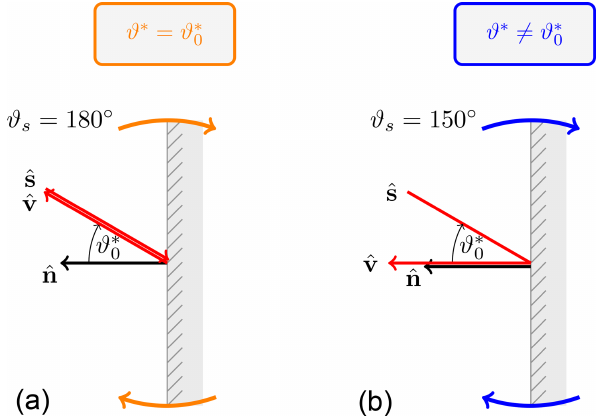
Figure 7. Two observation geometries with a scattering angle of ϑ s = 180 ◦ (a) and ϑ s = 150 ◦ (b) . The same cloud surface orien- tation ˆ n (cloud surface normal) and illumination ˆ s (solar direction vector) but different local viewing angle ϑ ∗ . The impact of the in- dicated cloud surface rotation on reflected radiances is shown in Fig. 8.